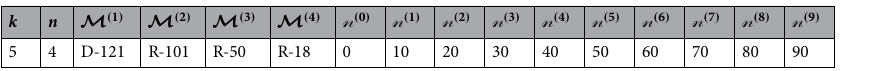
Table 5. Parameters used to test untrainable data cleansing (algorithm 1) for a multi-classification